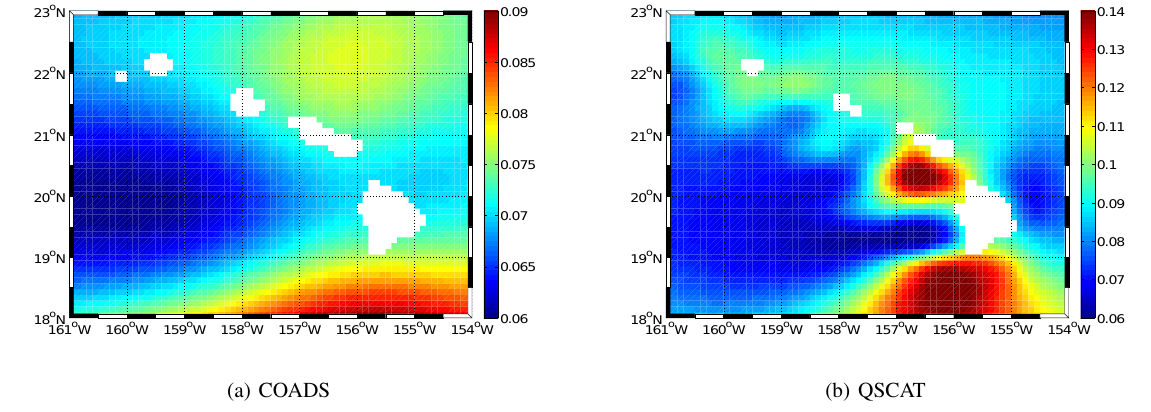
Fig. 5. Annually-averaged wind stress values [Nm − 2 ]. Different scales are used for a better visualization.